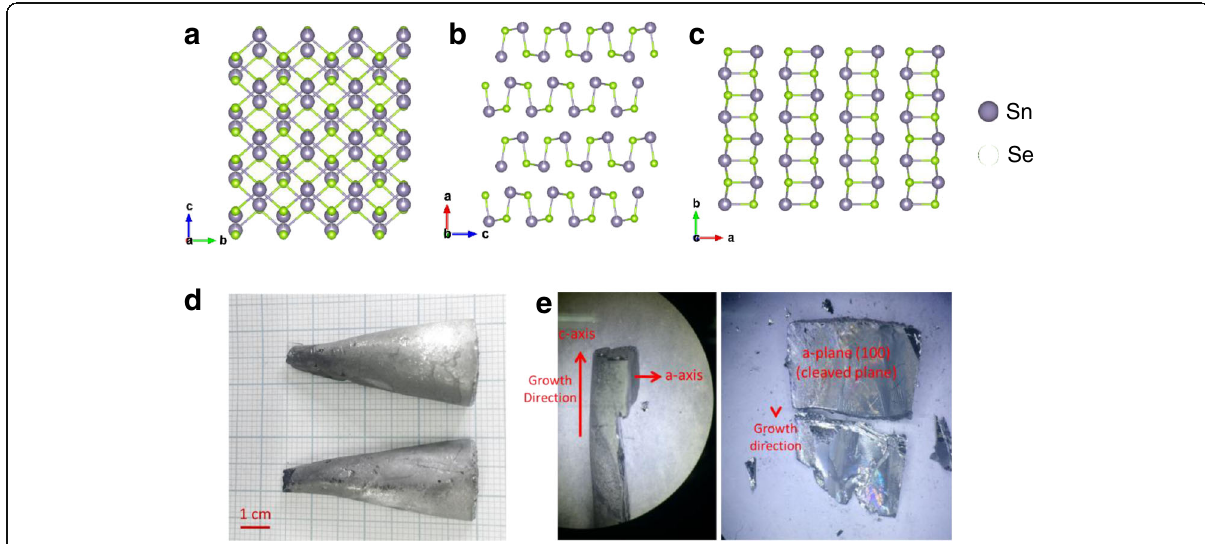
Fig. 1 a – c Crystal structure of SnSe crystals along a -, b -, and c -axial directions. d Photograph of a grown single-crystalline SnSe. e Photographs of cleaved SnSe crystals along the a -axis (100) plane. Top views of the cleaved plane (100) of the SnSe single crystal ( right image in d